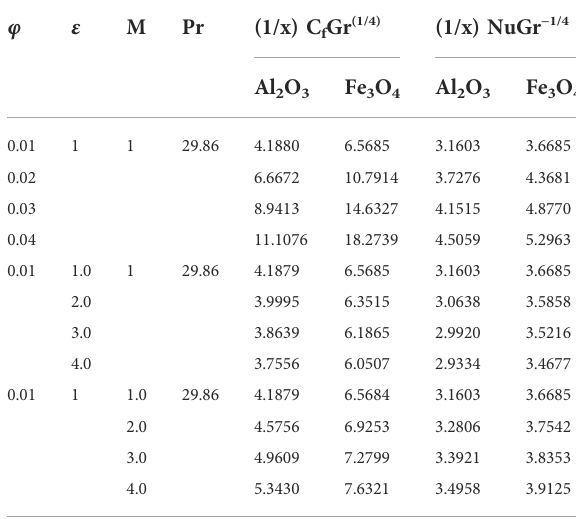
TABLE 3 The coef fi cient of skin friction and Nusselt